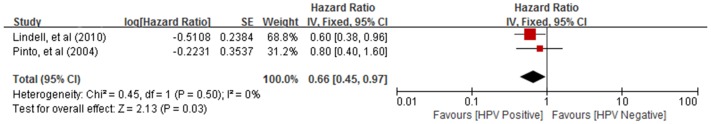
Forest plot for the association between human papillomavirus and recurrence-free survival in patients with vulvar cancer.